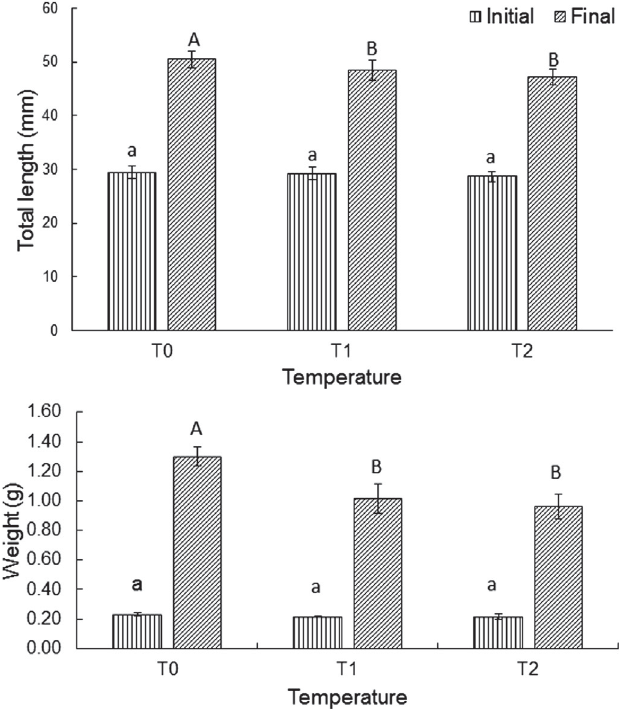
Fig. 2. Initial and fi nal length and body weight (mean values) of Macrobrachium amazonicum juveniles after 90 days of cultivation at different temperatures (T0: 28 ±0.5 ° C; T1: 30±0.2 ° C, T2: 32±0.5 ° C). Mean values followed by the same letters (lowercase) did indicate no difference for initial length and weight, and mean values followed by the same letters (uppercase) indicate no difference for fi nal length and weight according to the Dunn test ( P >